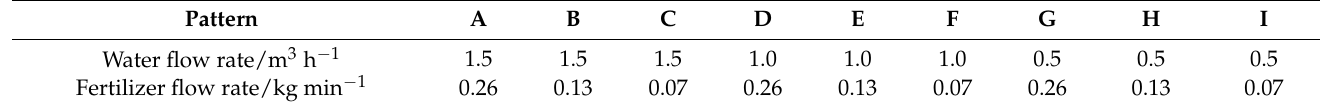
Table 1. Combined experiments of different fertilizer flow rates and water flow